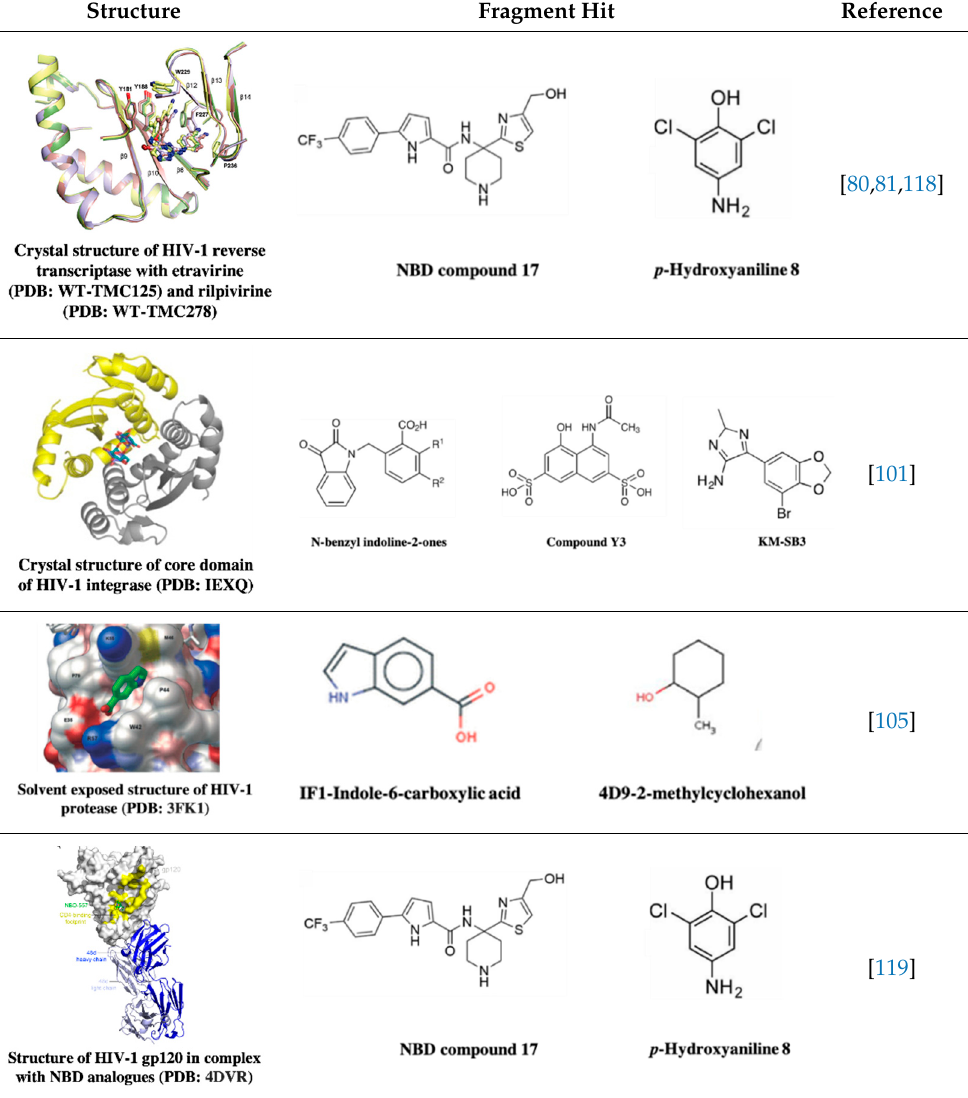
Table 5. HIV fragment molecules with their potency parameters.